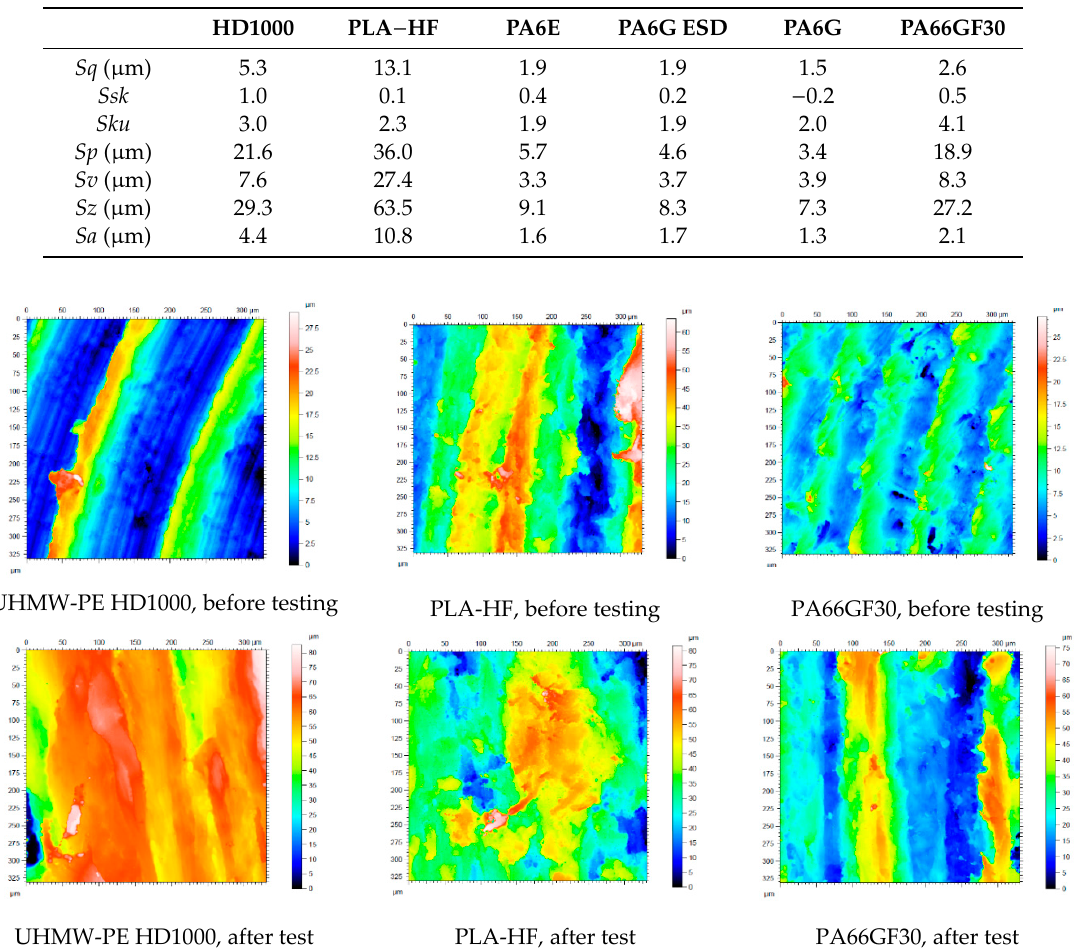
Figure 10. Some microscopic visualization of the change of surface 3D topography of the tested materials on P60 abrasive, applying the top speed and load (No. 6 condition, Table 1).